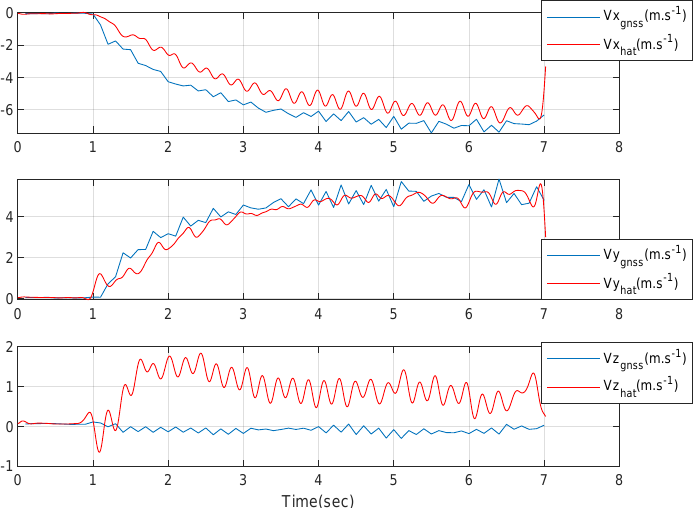
Figure 18. The 3-axis velocities of the athlete. Second, the performance of the designed GNSS/IMU loosely-coupled integration filter and the commercial high-precision GNSS/IMU AHRS were compared. The athlete ran back and forth at the stadium. Figures 19 and 20 show the planar trajectory of the athlete and the part of the trajectory of the athlete, respectively. The blue dots are the measured trajectory from GNSS in the wearable EPTS, the red dots are the estimated trajectory using the designed integration filter of the wearable EPTS, and the green dots are the estimated trajectory obtained from Microstrain’s 3DM-GX5 GNSS/IMU AHRS. The difference be- tween the estimated position may cause a difference in the GNSS receivers’ specifications. However, overall trajectories are very similar as shown in Figure 19. Moreover, the instan- taneous position data estimated using the designed integration filter are much smoother than those of the high-precision GNSS/IMU AHRS as shown in Figure 19.